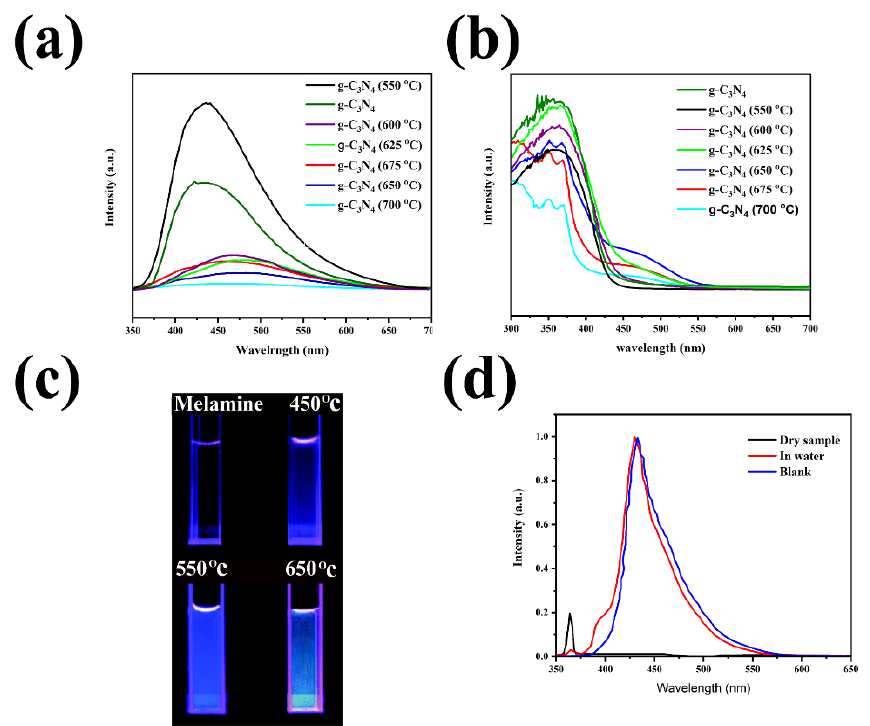
Figure 5. ( a ) The PL spectra under 325 nm excitation ( b ) UV-Vis spectra of g-C 3 N 4 , prepared at different temperatures, Copyright © 2022 American Chemical Society [41]; ( c ) The g-C 3 N 4 in deionized water under 365 nm light; ( d ) the PL spectra of the g-C 3 N 4 , g-C 3 N 4 in water and in the DI water [44].